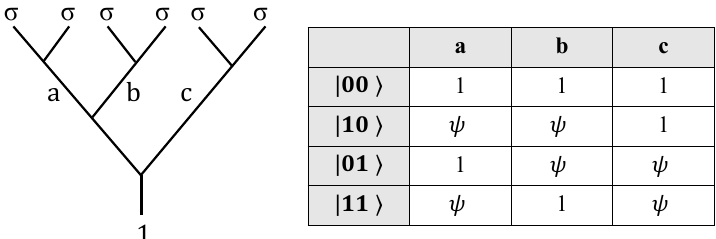
Figure 7: The fusion diagram for six Ising anyons for a pairwise basis restricted to the global vacuum sector. Due to the fusion rules σ × σ = 1 + ψ and σ × ψ = σ , the fusion diagram contains four distinct fusion channels that are consistent with the constraint that the fusion of all the six σ anyons must give the vacuum 1. The table shows the identification of the fusion channels with the computational basis of two